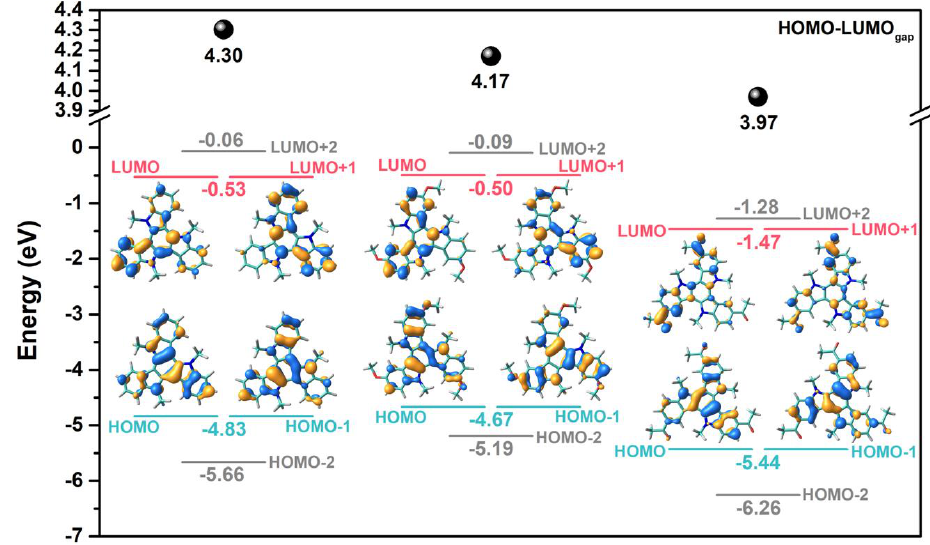
Figure 3. DFT-calculated molecular orbital energies and topologies for 1 – 3 compounds at the B3LYP/6-31G** level of theory.